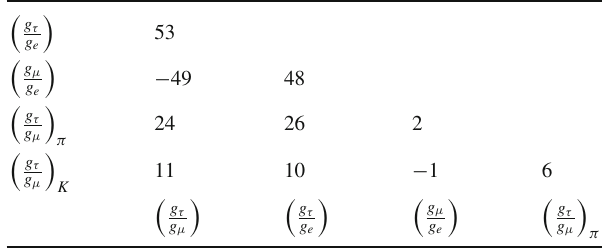
Table 315 Universality coupling ratios correlation coefficients (%)